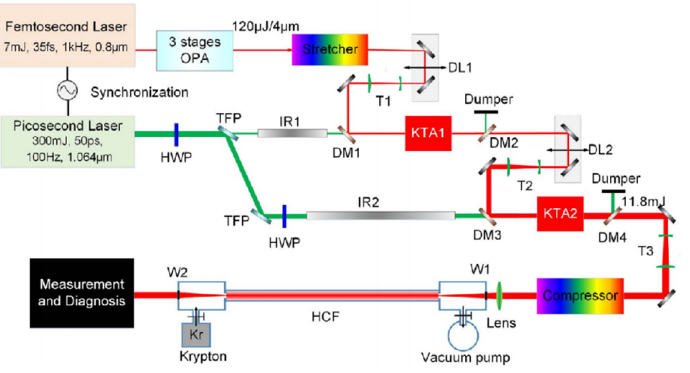
Figure 10. Schematic of the 4 μ m OPCPA and post-compression system. Reprinted with permission from [53]. Table 4. Parameters of the long-wavelength MIR OPCPA